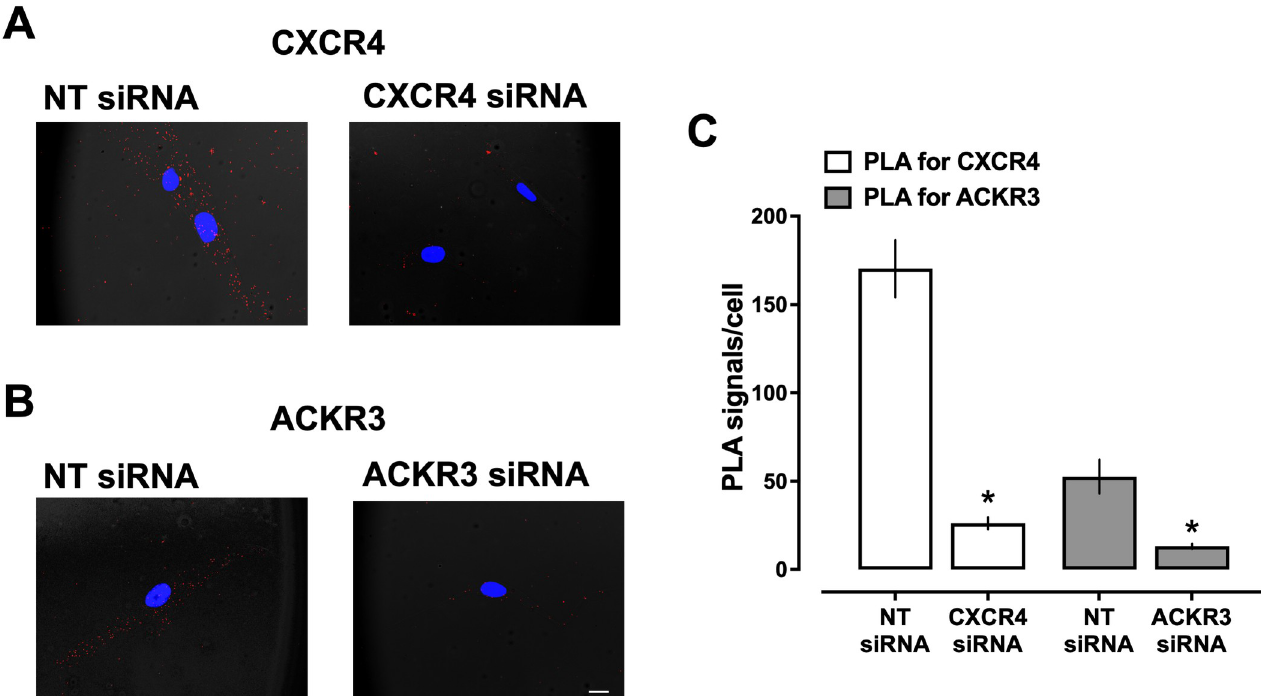
Fig 4. siRNA knockdown of CXCR4 and ACKR3 in hVSMCs. ( A ) Representative PLA images for the detection of CXCR4 in hVSMC after incubation with non-targeting (NT) or CXCR4 siRNA. Images show merged PLA/4 0 ,6-diamidino-2-phenylindole dihydrochloride (DAPI) signals. ( B ) Representative PLA images for the detection of ACKR3 in hVSMC after incubation with NT or ACKR3 siRNA. Images show merged PLA/4 0 ,6-diamidino-2-phenylindole dihydrochloride (DAPI) signals. Scale bar = 10 μ m. ( C ) Quantification of PLA signals for the detection of CXCR4 and ACKR3 after incubation with siRNA, as in A/B. N = 3 independent experiments with n = 10 images per experiment. � : p < 0.05 vs. cells incubated with NT siRNA.